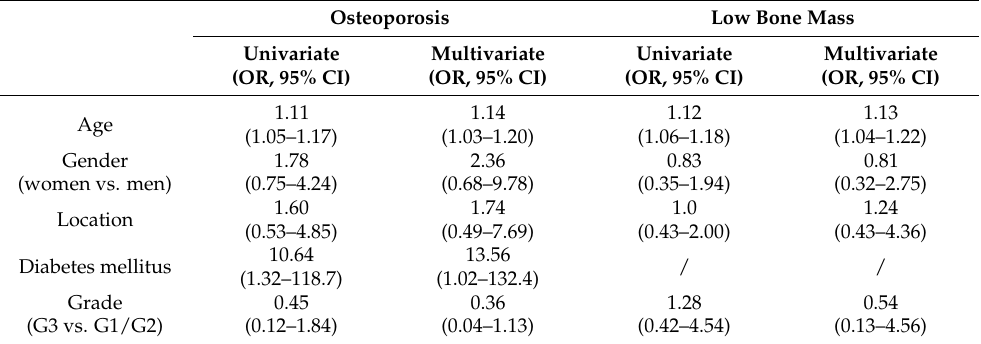
Table 2. Associations between variables and osteoporosis and low bone mass in pancreatic neuroen- docrine tumors